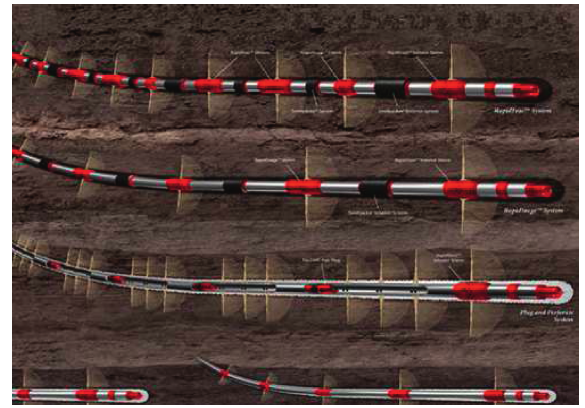
Figure 7: Schematic diagram of multilevel horizontal well for conglomerate formation in vertical